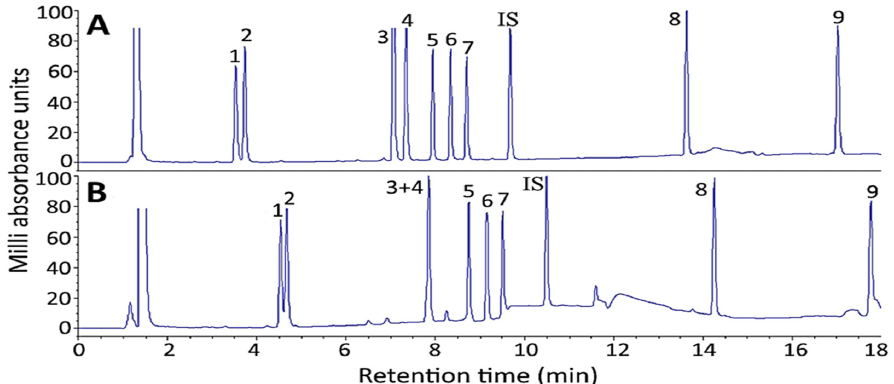
Figure 4. Effect of column type on separation efficiency of 10 ginsenoside standards including internal standard saikosaponin A by HPLC. ( A ), Supelco Ascentis ® Express C18 column; ( B ), Waters Cortecs ® T3 C18 column. Separation conditions: column dimension, 150 × 4.6 mm ID and particle size 2.7 µ m; mobile phase, deionized water and acetonitrile; flow rate, 1 mL/min; column temperature, 50 ° C; detection wavelength, 205 nm. Peaks: 1, Re; 2, Rg1; 3, Rf; 4, Rb1; 5, Rc; 6, Rb2; 7, Rd; IS (internal standard), saikosaponin A; 8, Rg3; 9, CK.